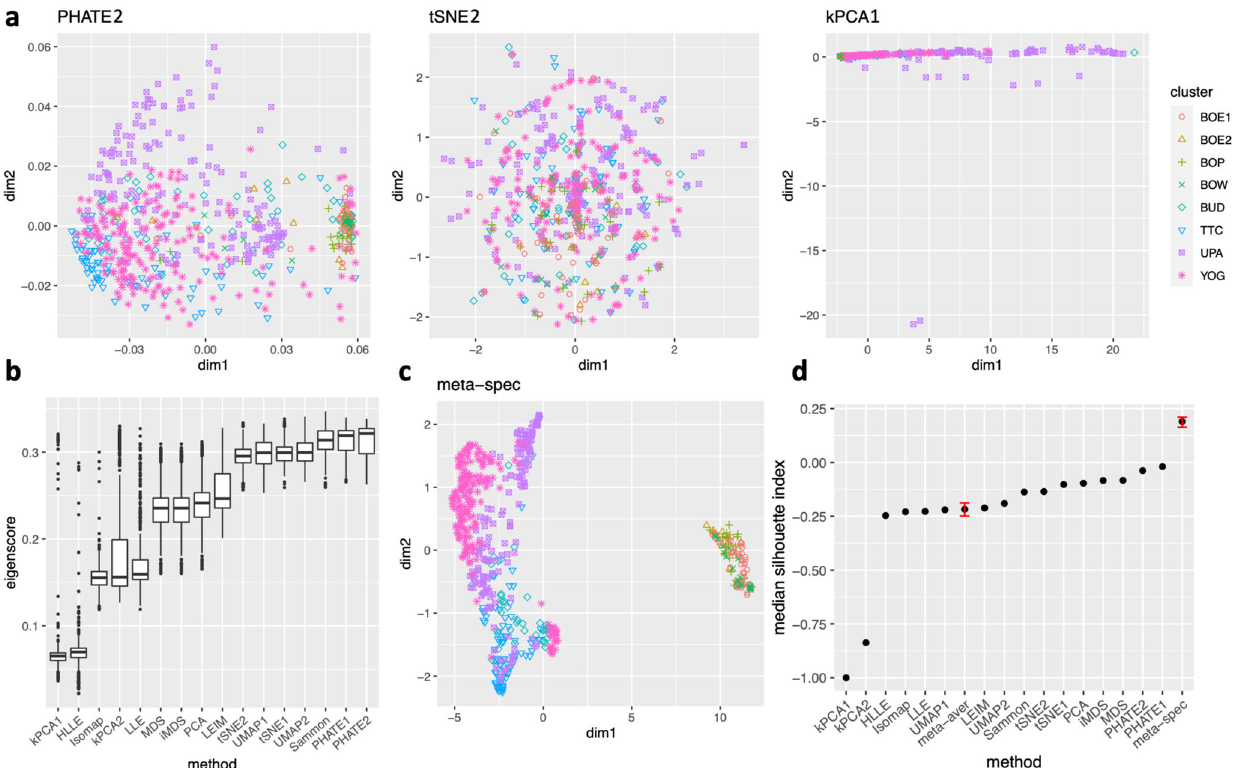
Fig.3|Visualizationof590fragmentsoftextsfromeightreligiousandbiblical books.a Three examples of candidate visualizations. The samples are marked by eight different symbols and colors according to their associated books. More examples are included in Supplementary Fig. 5. b Boxplots (center line, median; box limits, upper and lower quartiles; points, outliers) of eigenscores for all 16 candidate visualizations, each containing n = 590 samples. c The